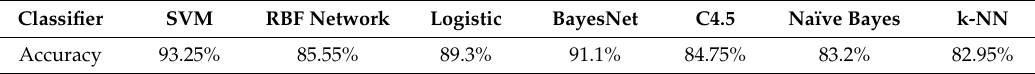
Table 6. The quantitative results of different classifiers.